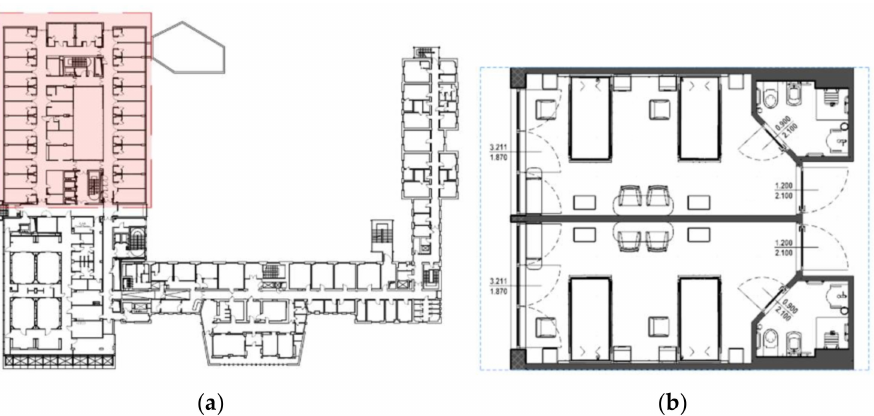
Figure 1. Careggi General Hospital of Firenze; ( a ) on the left side: the maternity ward layout (marked in red); ( b ) on the right side: a typical two-bed coupled rooms